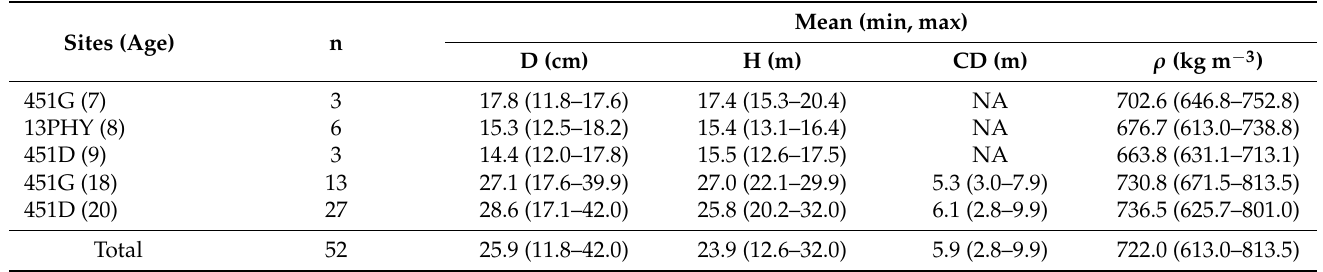
Table 1. Study sites, stand age, summary of predictors of sample trees for developing allometric equations. Abbreviations as follows: n, total number of trees sampled; D, diameter at breast height (cm); H, total tree height (m); CD, crown diameter (m); and ρ , wood density (kg m − 3 ). For each of D, H, CD and ρ , mean, minimum and maximum values are